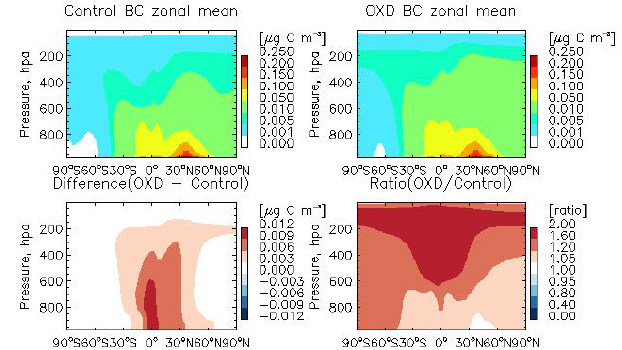
Fig. 3c. Same as Fig. 3a but for zonal mean.